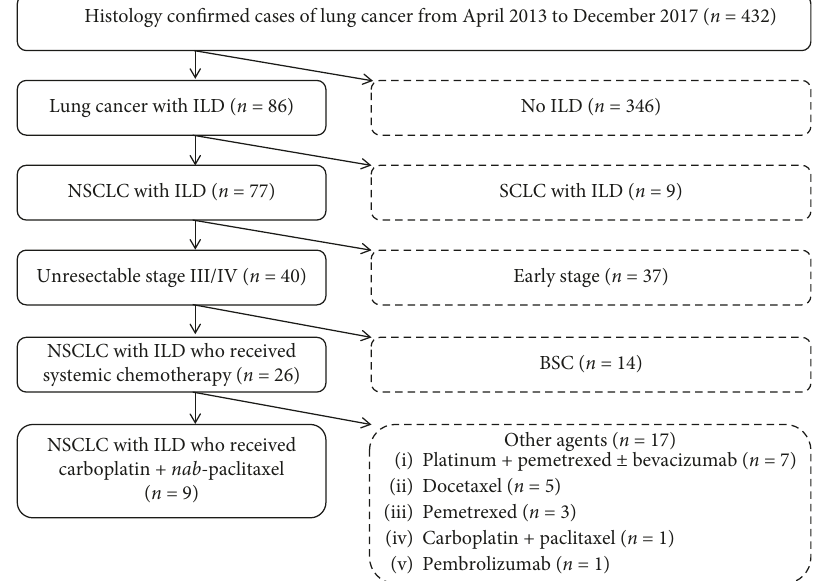
Figure 1: CONSORT diagram. ILD: interstitial lung disease; NSCLC: non-small-cell lung cancer; SCLC: small-cell lung cancer; BSC: best supportive